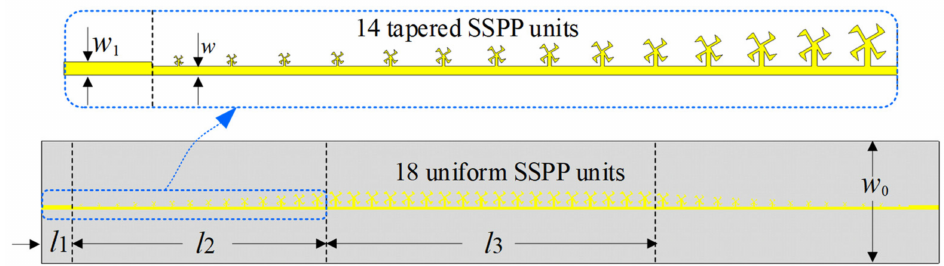
Figure 3. Schematic diagram of the proposed windmill-shaped SSPP waveguide with conversions, where l 1 = 5 µ m, l 2 = 70 µ m, l 3 = 60 µ m, w 1 = 20 µ m. Then, we simulate the frequency responses of the windmill-shaped SSPP